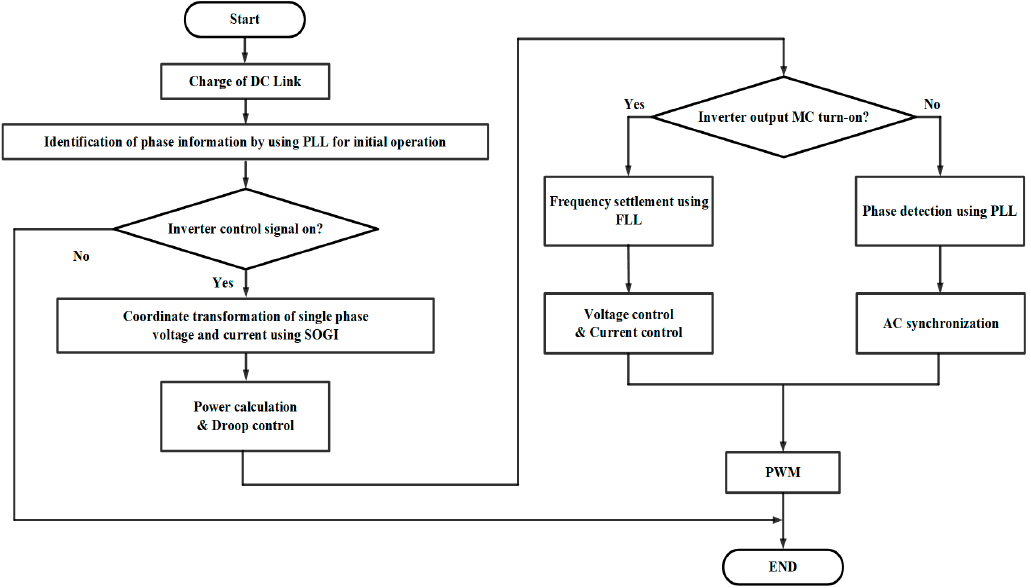
Figure 12. System operation sequence of droop-controlled parallel-inverter.